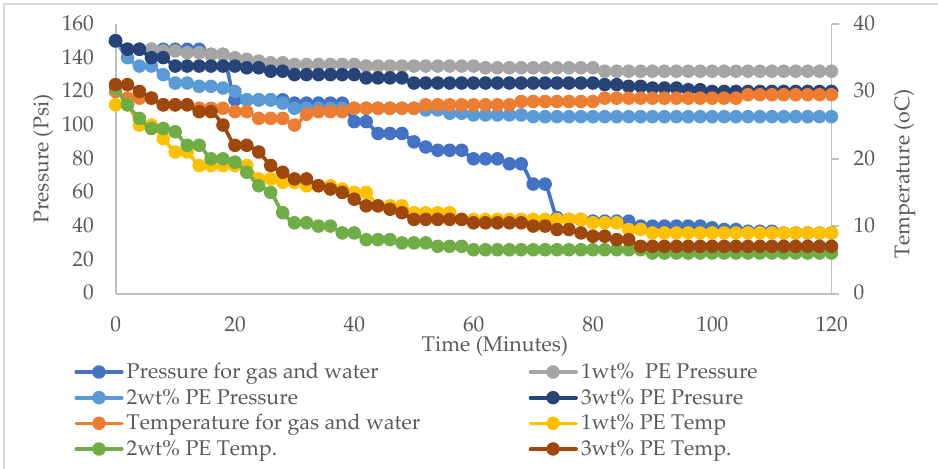
Figure 4. Pressure and Temperature versus Time for 1, 2 and 3 wt% Plant Extract (PE). 3.1. Hydrate Equilibrium Pressure-Temperature Plots for 1, 2, and 3 wt% PE and Uninhibited Experiment (Water and Gas)